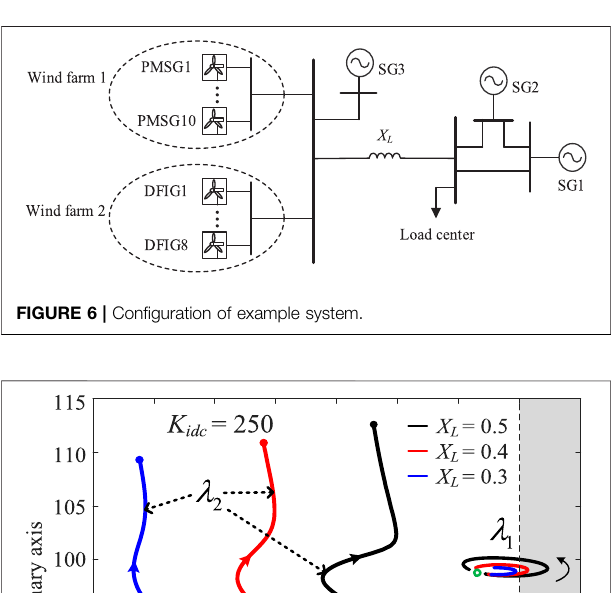
Frontiers in Energy Research |